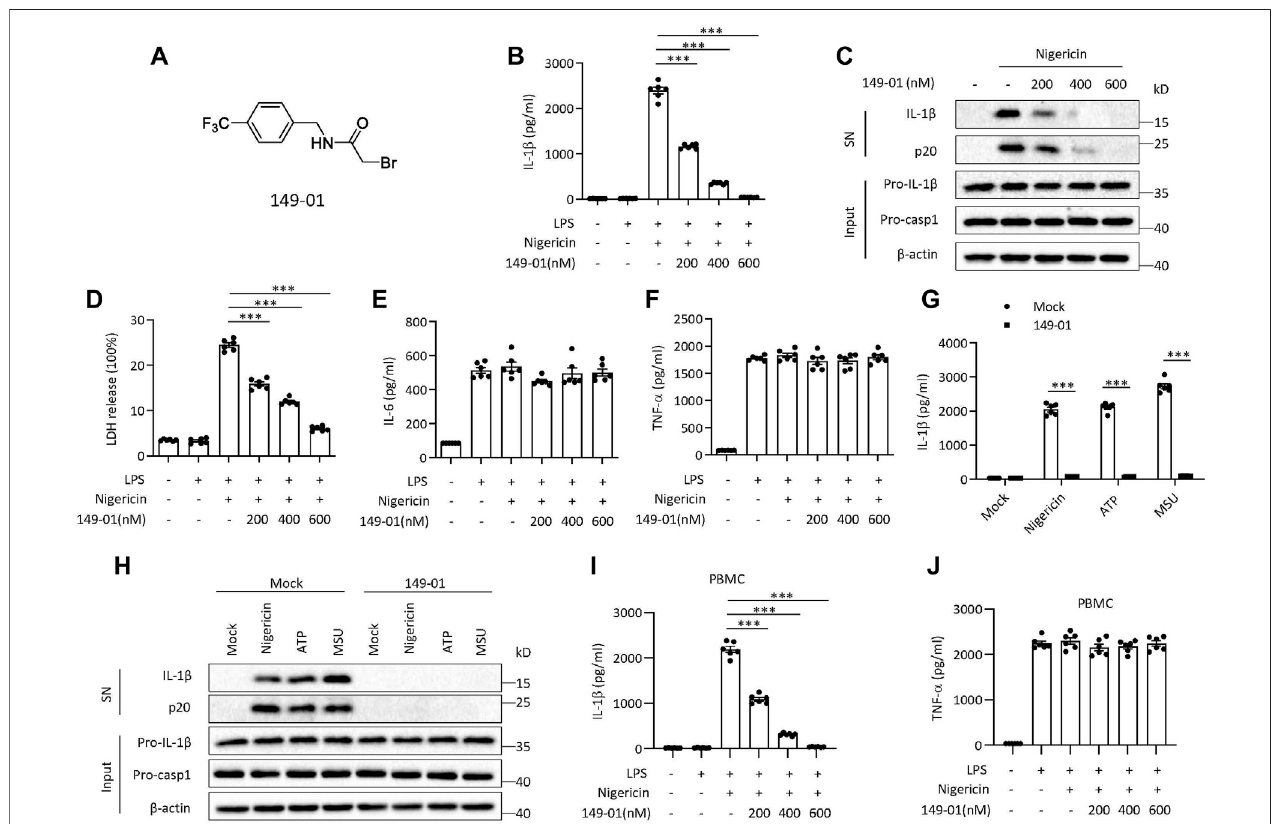
FIGURE 1 | Identi fi cation of 149-01 as a highly potent inhibitor for NLRP3 in fl ammasome. (A) 149-01 structure. (B – F) BMDMs were fi rst primed with LPS for 3 h, then pretreated with indicated doses of 149-01 (200-600 nM) for 30 min, lastly stimulated with nigericin. (B) IL-1 β releases in supernatants were detected by ELISA. (C) Active IL-1 β and p20 (cleaved caspase-1) in supernatants (SN) and pro-IL-1 β , pro-caspase-1 and β -actin in cell lysates (Input) were measured by western blot. (D) The release of LDH in supernatants. (E) IL-6 and (F) TNF- α secretion levels in supernatants were determined by ELISA. (G,H) BMDMs were fi rst primed with LPS, then treated with or without 149-01 (600 nM) for 30 min, lastly stimulated with nigericin, ATP or MSU. (G) IL-1 β releases in supernatants were detected by ELISA. (H) Active IL-1 β and p20 in supernatants and pro-IL-1 β , pro-caspase-1 and β -actin in cell lysates were measured by western blot. (I,J) PBMCs were fi rst primed with LPS for 3 h, then pretreated with indicated doses of 149-01 for 30 min, lastly stimulated with nigericin. (I) IL-1 β and (J) TNF- α secretion levels in supernatants were determined by ELISA. Data are obtained from three independent experiments, each with two biological replicates and are expressed as mean ± s. e.m ( n = 6) (B,D – G,I,J) , or are representative of three independent experiments (C,H) . One-way ANOVA was applied to calculate statistical signi fi cance: *** p < .001.